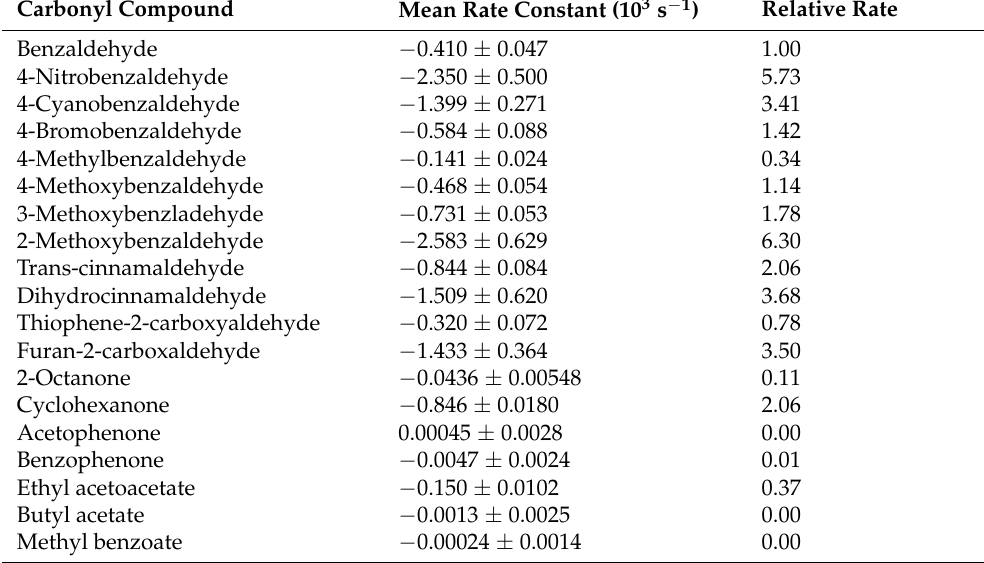
Table 4. Carbonyl ’s reactivity with isoniazid.